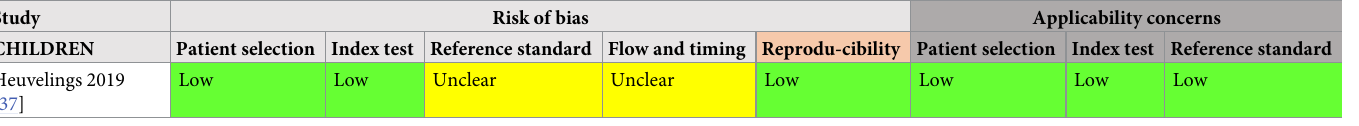
Low = low risk/concern; High = high risk/concern; Unclear = unclear